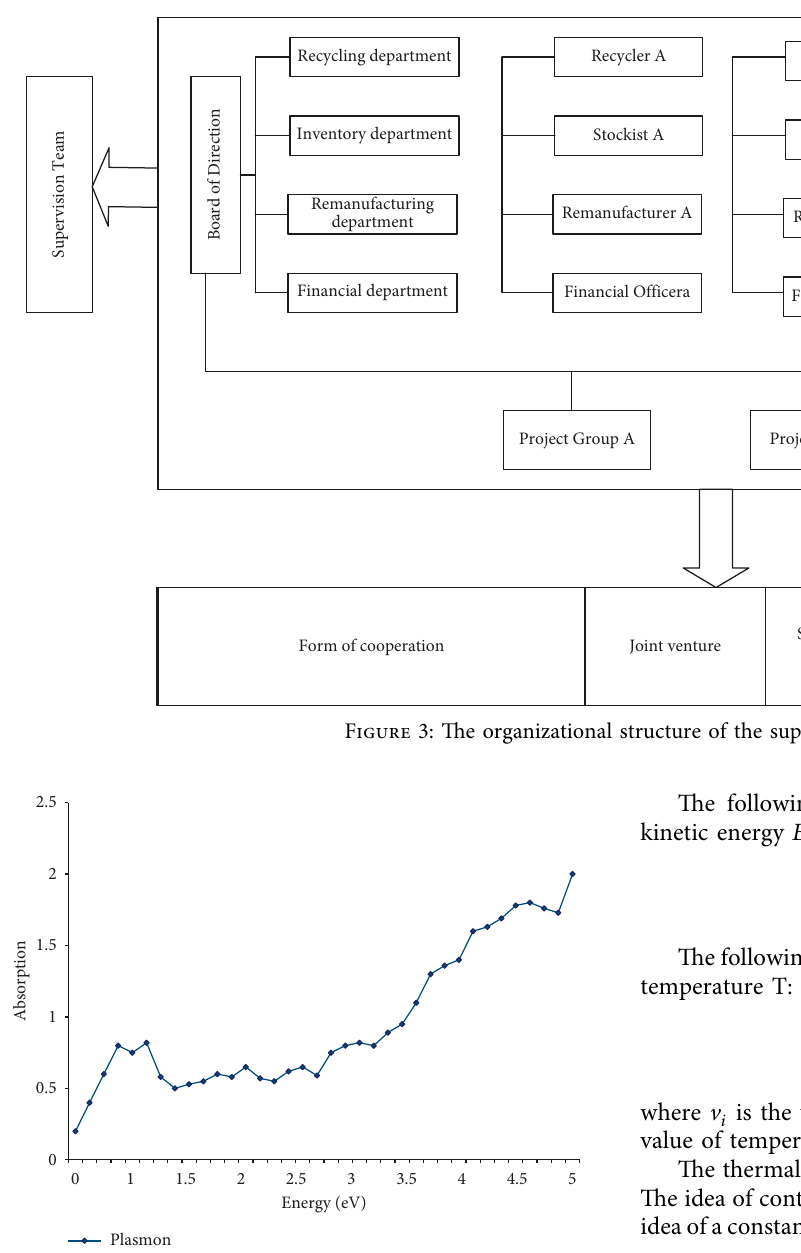
Figure 4: Absorption curve of carbon